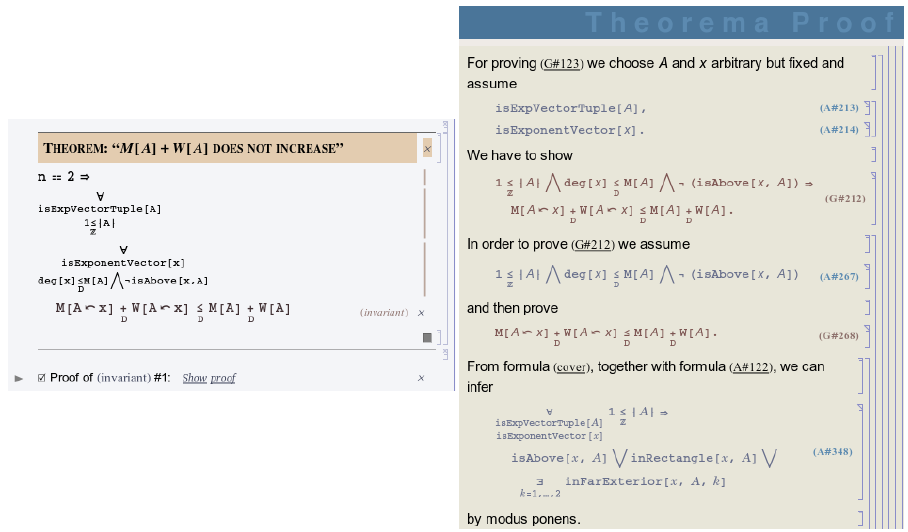
Fig. 5. Theorema 2.0 formula stating that M ( A ) + W ( A ) does not increase when adding a new element x to A (left), together with a fragment of its Theorema-generated proof